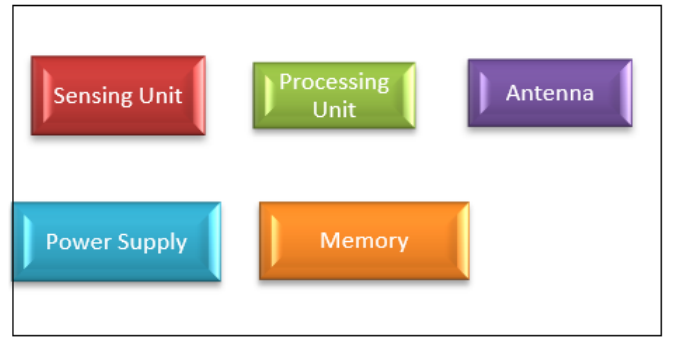
Figure 1. WSN’s components.